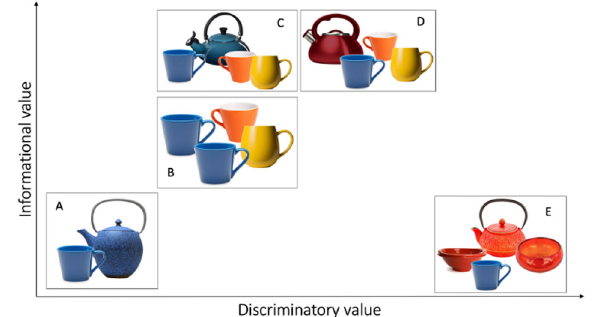
Fig. 1 Visualization of the informational vs. discriminatory value of the color adjective “ blue ” in the description “ the blue cup ” . In Displays A and E , “ blue ” has no informational value because there is only one cup (i.e., color does not pre-empt an ambiguity). In Display B , “ blue ” has more informational value because there are several cups, but not enough to secure unique reference amongst them. In Displays C and D , “ blue ” has the highest informational value because it resolves reference among all cups. Regarding discriminatory value, “ blue ” has none in Display A because both objects are blue, whereas it has more in Displays B and C because two of the four objects are blue. In Display D , “ blue ” has higher discriminatory value because there is a single blue object, and it has even more in Display E because it relies on a pop-out effect (i.e., the uniform color of the other objects makes the color blue stand